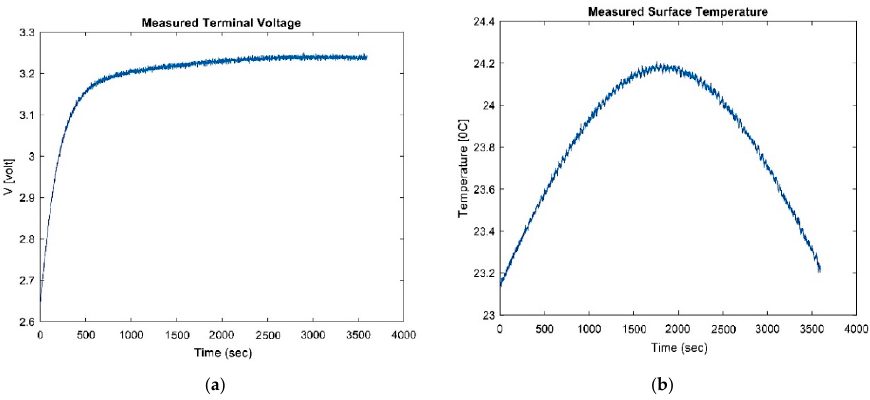
Figure 5. Systems outputs; ( a ) SOC%, ( b ) terminal voltage, ( c ) SOH%, and ( d ) temperature changing. With adding white noises to both surface temperature and terminal voltage data with